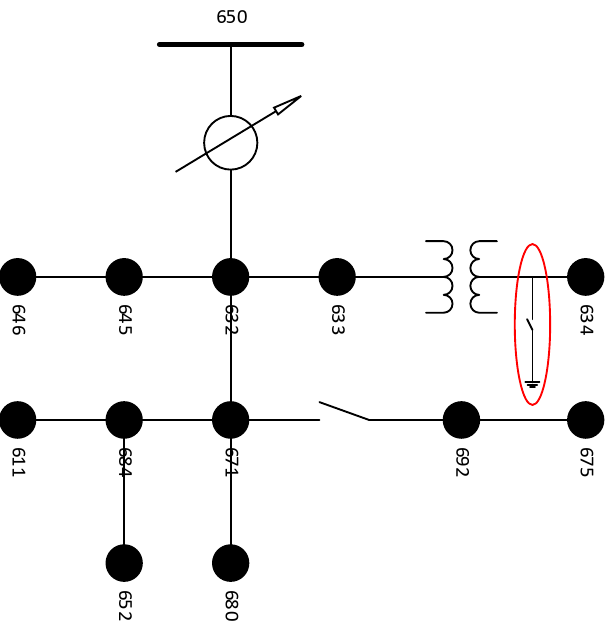
Figure 6. Phase-to-earth short circuit occurrence point—Case study 2.